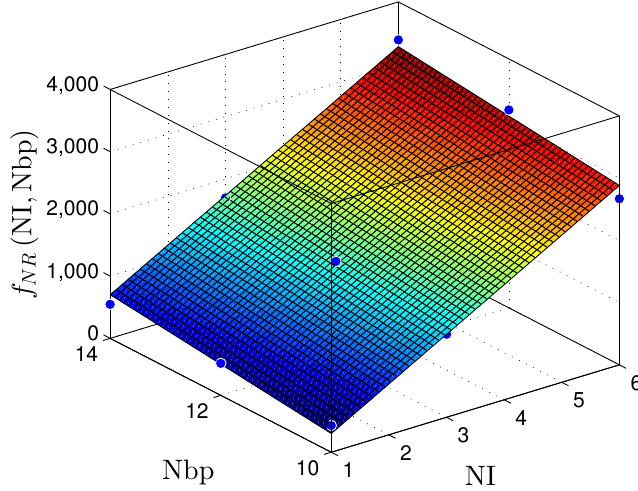
Figure 19. Plane, f NR ( NI , W ) , found to estimate the number of registers, NR, as a function of the number of implementations, NI, and the number of bits in fractional part W for ML-based prediction techniques.